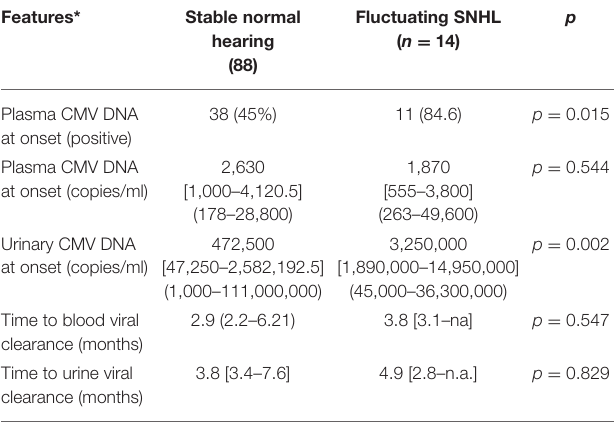
TABLE 5 | SNHL in asymptomatic